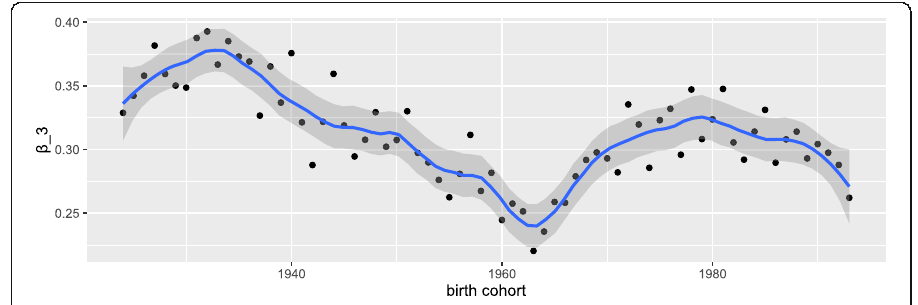
Fig. 4 Yearly variation in the effect of parents ’ education on respondents ’ years of